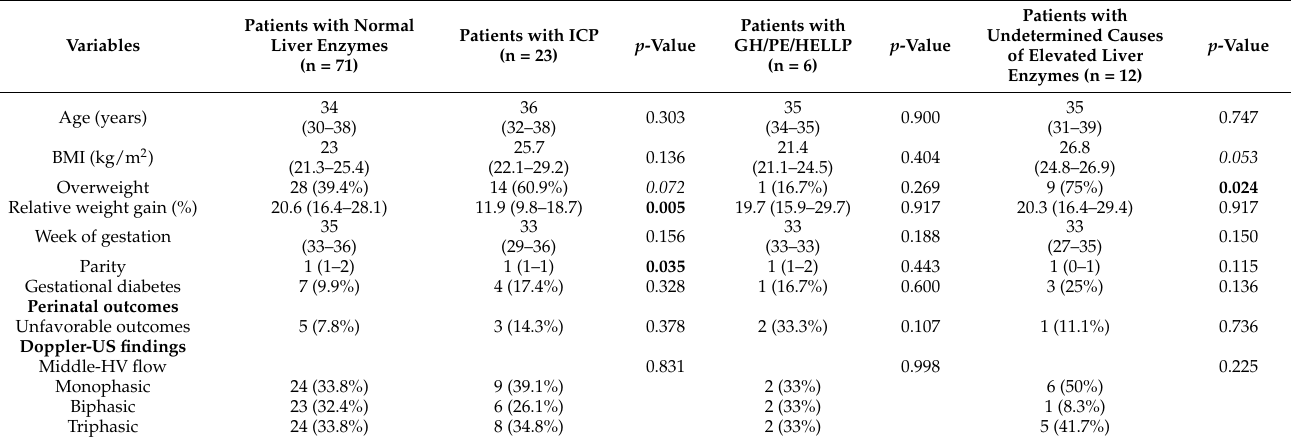
Table 2. Characteristics of the pregnant patients with normal liver enzymes and with pregnancy- related liver